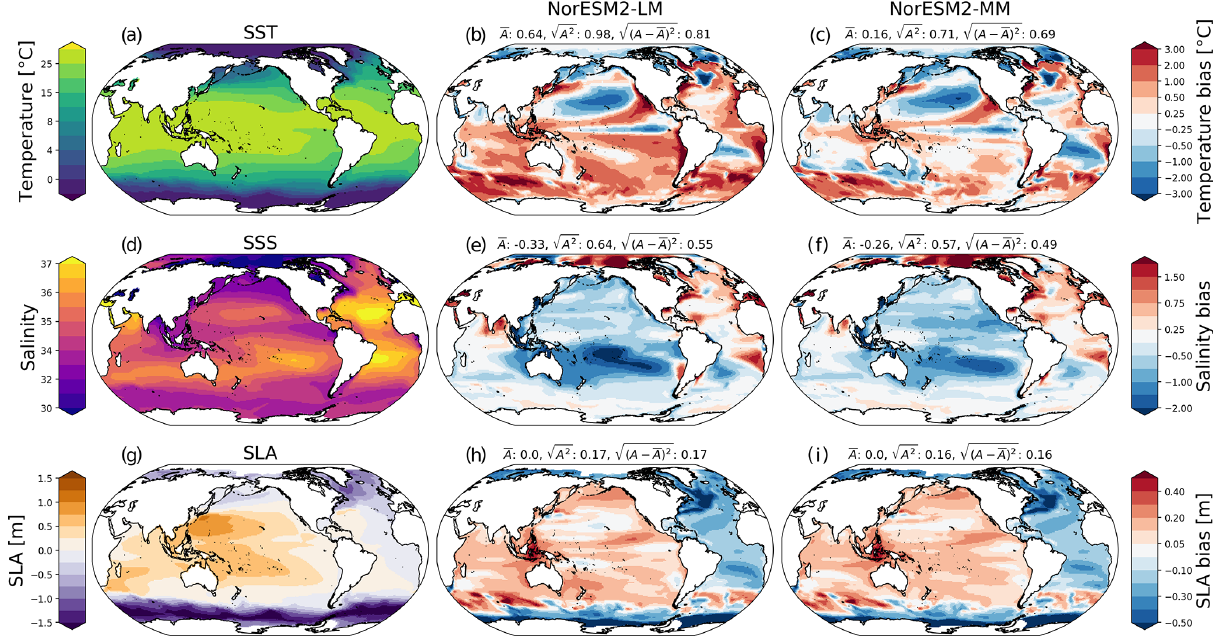
Figure 9. Observed climatologies (a, d, g) and biases for NorESM2-LM (b, e, h) and NorESM2-MM (c, f, i) for SST, sea-surface salinity (SSS), and SLAs. SST and SSS are compared to the World Ocean Atlas climatology (Locarnini et al., 2018; Zweng et al., 2018) between 1981 and 2010, whereas SLA is compared to Aviso altimetry between 1993 and 2010. For the model biases, we show the ensemble-mean bias using three historical members. Note that A is the anomaly between the model and the observation, and we report the global-mean bias √ (cid:112) A 2 ), and global-mean RMSE with the mean bias first removed ( (A − A) 2 ). SLA is ( A ), global-mean RMSE (root-mean-square error; redefined to have zero mean over the ice-free region in the observational dataset (thus, A is 0 by